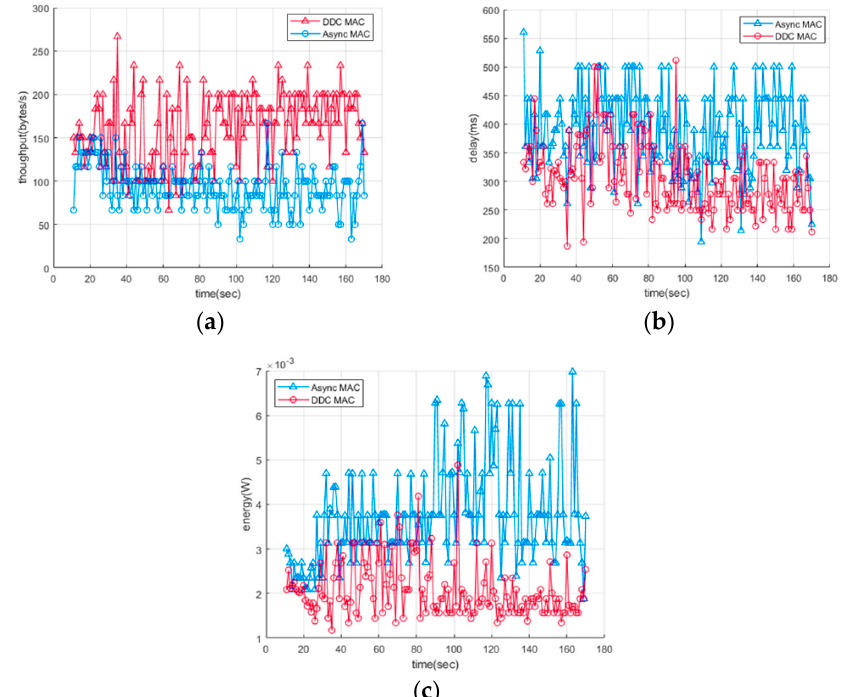
Figure 6. The comparison of the asynchronous MAC protocol and DDC-MAC traffic amount: ( a ) throughput; ( b ) delay; ( c ) energy consumption/s/node.